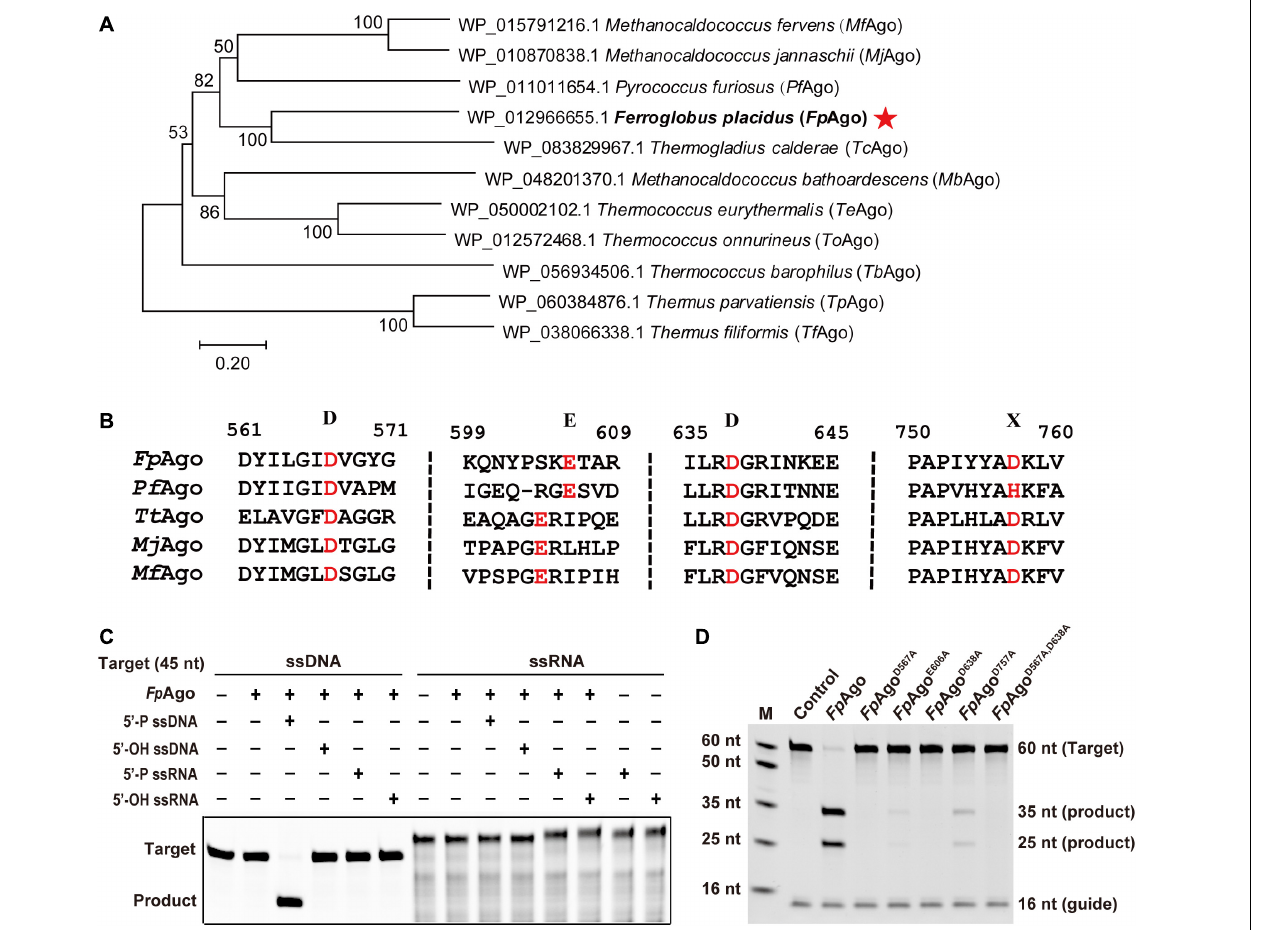
FIGURE 1 | Phylogenetic analysis and cleavage activity assay of Fp Ago. (A) Neighbor-joining phylogenetic tree analysis of Fp Ago (marked by asterisks) based on amino acid sequences. The numbers at the nodes indicate the bootstrap values for neighbor-joining analysis of 1,000 resampled data sets. The scale bar represents the evolutionary distance between species. (B) Multiple sequence alignment of conserved amino acid residues (marked by red) of the DEDX tetrad localized in the PIWI domain of pAgos. (C) Guide and target preferences of Fp Ago. Cleavage activity assays of Fp Ago were performed with 45 nt FAM-labeled ssDNA or ssRNA target in reaction buffer containing 0.5 mM Mg 2 + for 15 min at 95 ◦ C. (D) Cleavage activity of Fp Ago and its DEDD mutants. M, ssDNA marker; nt, nucleotide. The “Control” sample contains no